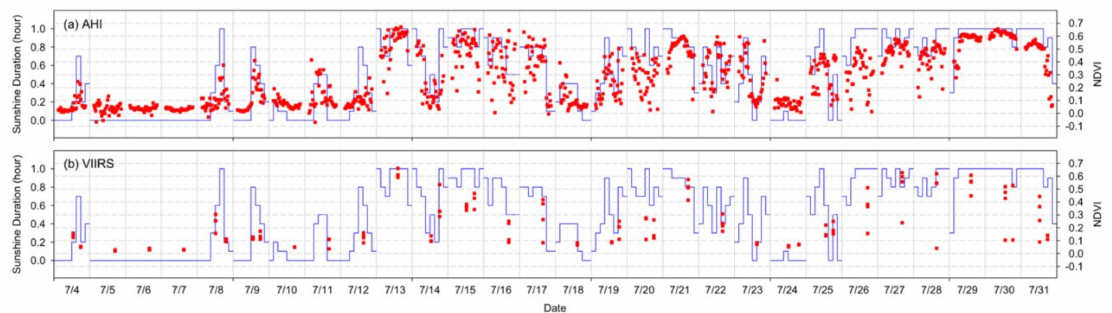
Figure 7. AHI NDVI ( a ) and VIIRS NDVI ( b ) plotted along with sunshine durations at Asakura station (N 33 o 24.4 (cid:48) , E 130 o 41.7 (cid:48) , 38 m ASL), Fukuoka, Japan. Plotted in Figure 7b are VIIRS NDVI values extracted over a 2 pixel by 2 pixel window corresponding to the AHI NDVI extraction location (i.e., four pixels). As a wide-swath sensor in near-polar sun-synchronous orbit, VIIRS acquired one or two observations per day. Based on the NDVI values supported by the sunshine duration data, VIIRS also acquired the first clear-sky observations on 13 July and all of the four pixel observations were cloud-free. The next clear-sky observations were acquired on 27, 28, and 29 July where two, one, and one observations out of the four were cloud-free, respectively (Figure 7b). In contrast to AHI, no cloud-free observations were acquired with VIIRS on 15, 21, and 30